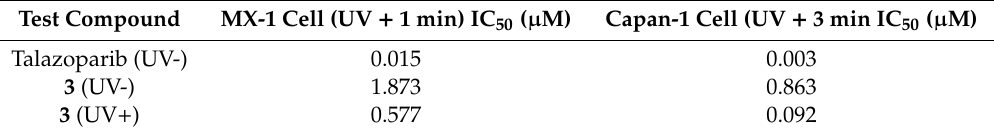
showed left-shifted dose–response curve compared to that of the unirradiated compounds. Error bars represent the standard deviation from duplicate determinations, and results are shown as mean ± SD. The IC 50 value is presented in Table 3. Table 3. Capan-1 and MX-1 cell inhibitory activities of Talazoparib and compound 3 in the absence and presence ultraviolet radiation.